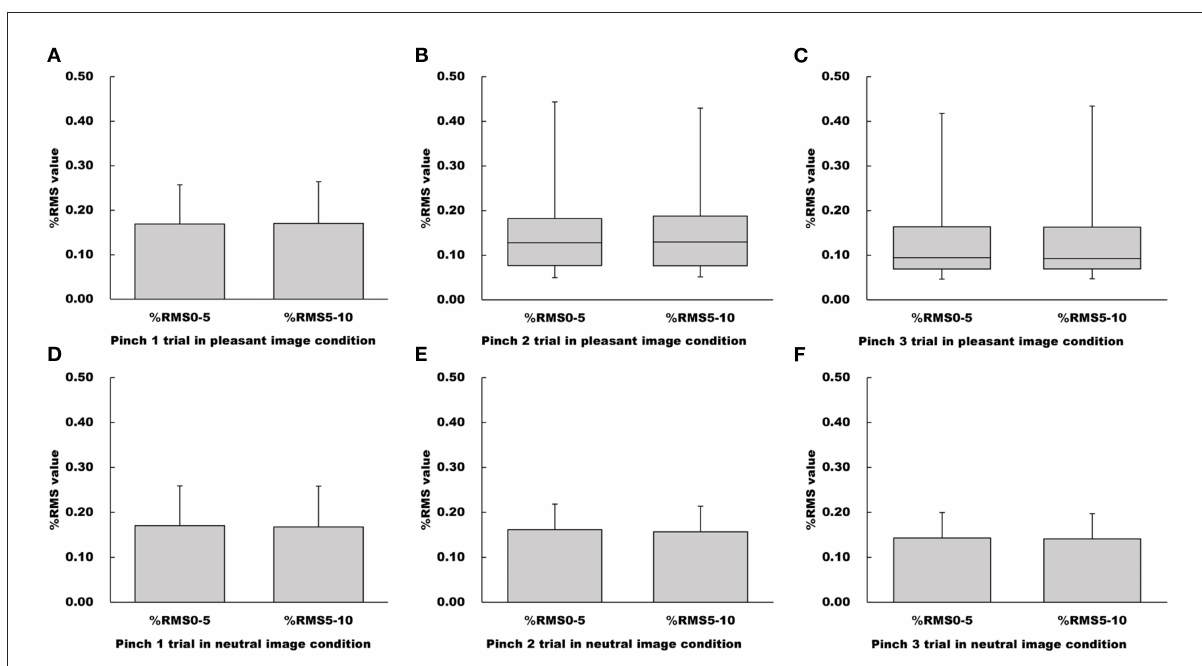
FIGURE5 Influence of duration on %RMS values in the pleasant and neutral image conditions. (A–C) Show %RMS value in the pleasant image condition, respectfully. (D–F) Show %RMS value in the neutral image condition, respectfully. For parametric data, %RMS values are represented as mean and standard deviation. For non-parametric data, %RMS values are represented using the box and whisker plot, with the median shown as the middle horizontal line, the upper and lower quartiles indicated as boxes, and the maximum and minimum indicated as whiskers. The vertical axis shows %RMS value, and horizontal axis shows the specific duration (%RMS 0 − 5 and %RMS 5 − 10